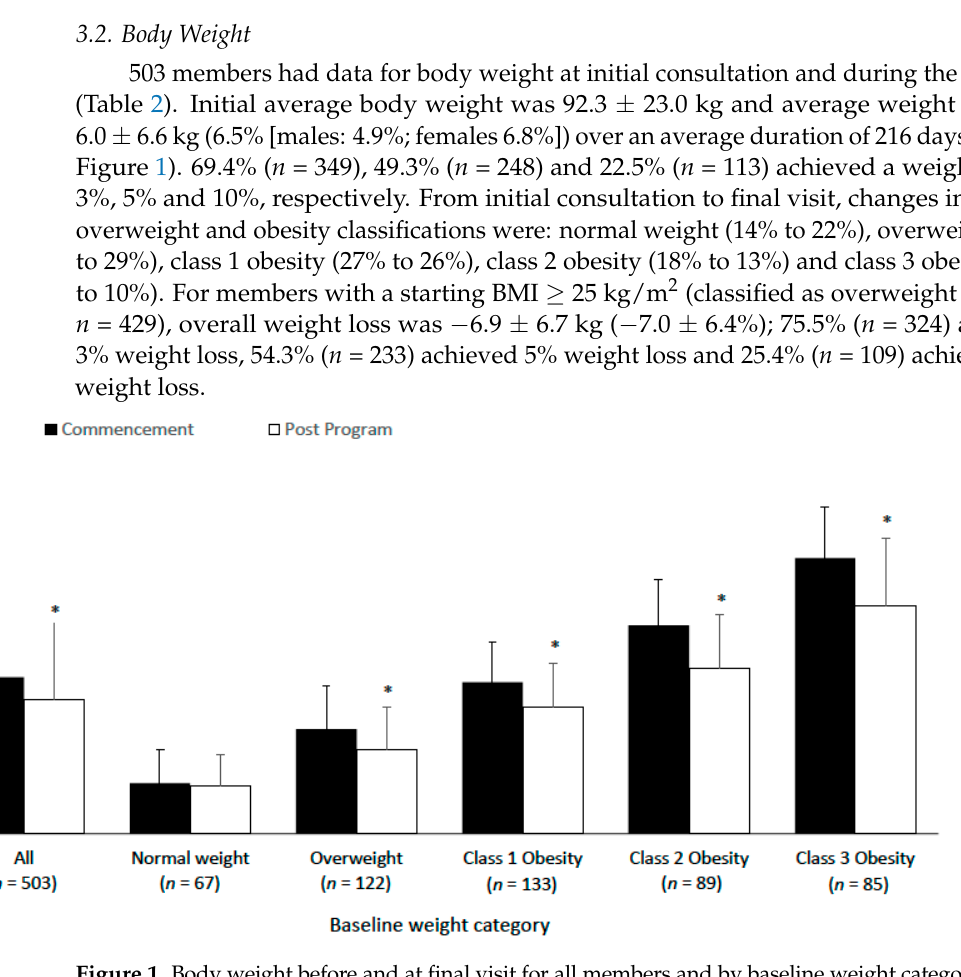
Figure 1. Body weight before and at final visit for all members and by baseline weight categorisation of normal weight (BMI: 18.5–24.9 kg/m 2 ), overweight (25–29.9 kg/m 2 ), class 1 obesity (30–34.9 kg/m 2 ), class 2 obesity (35–39.9 kg/m 2 ), class 3 obesity (40+ kg/m 2 ). Values are mean ± standard deviation. * p < 0.001 significantly lower compared to commencement.